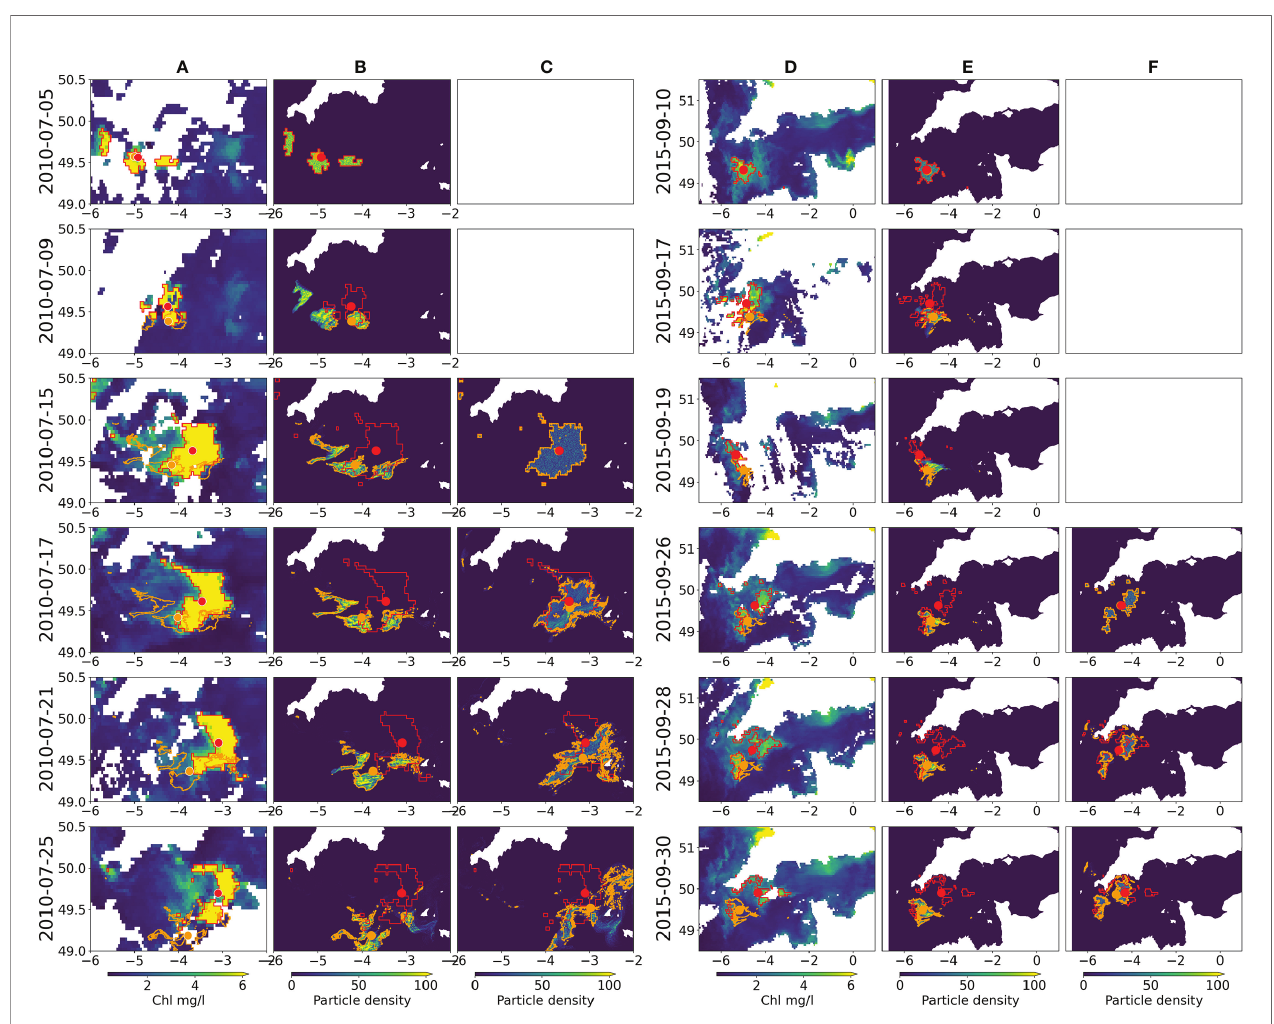
FIGURE 2 | Remote sensing Chl (A, D) , and particle densities from the fi rst release (B) and re-release (C) in the July 2010 (A – C) and September 2015 (D – F) events. The selected images, which show the progression of each bloom, are chosen for being the clearest remote sensing data, hence the uneven date distribution. Identi fi ed areas of high Chl from the remote sensing are marked inside red polygons with the centre of mass marked by a red spot. Areas of high particle density are shown in orange with the corresponding centre of mass shown by orange